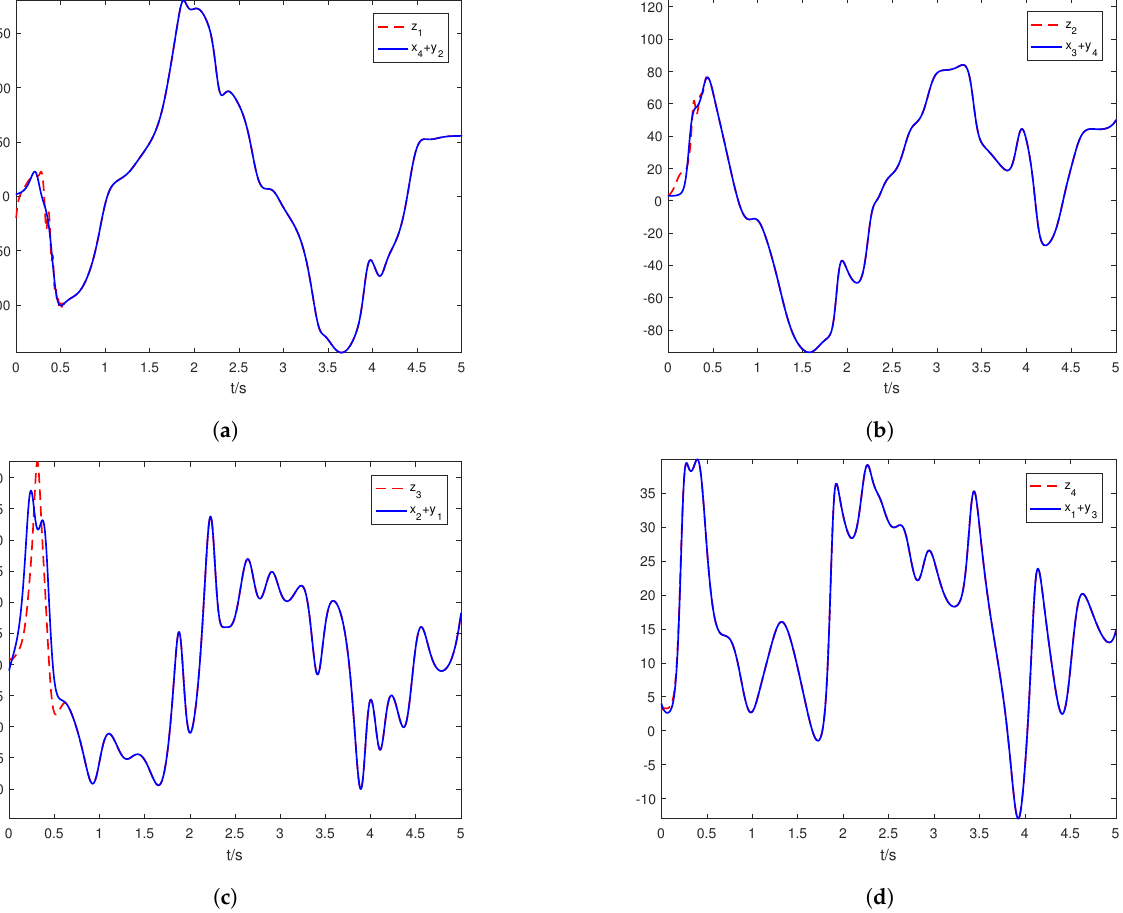
Figure 3. The synchronization for state variables z 1 and x 4 + y 2 , z 2 and x 3 + y 4 , z 3 and x 2 + y 1 , z 4 and x 1 + y 3 of drive systems (31), (32) and response system (33) indicating in sub-pictures ( a – d ),